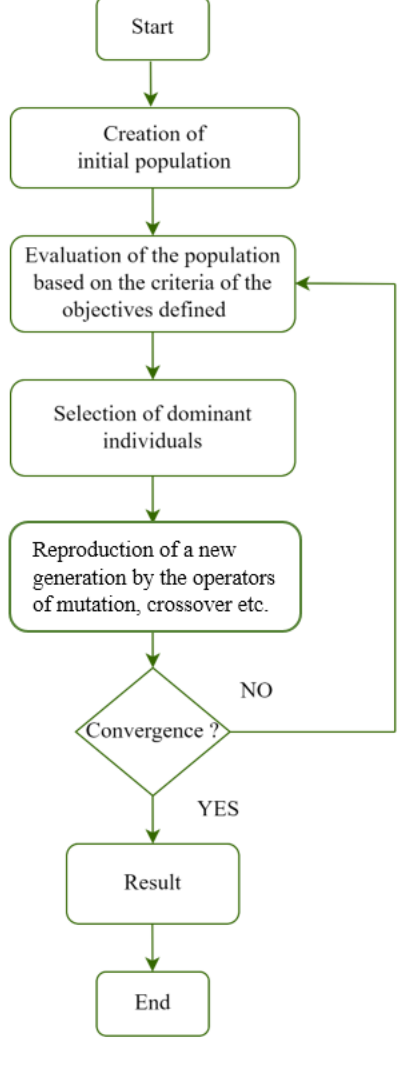
Figure 5. GA optimization procedure. Table 6. The parameters of tuning in the GA program of optimization.